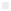
Solubility of CO2, CH4, C2H6 and H2S in DESs at 25°C and 1 bar for different combinations of salts and HBDs.Solubility index range 0–0.0003 (■), 0.00035–0.1 (■) and 0.15–0.5 (■).